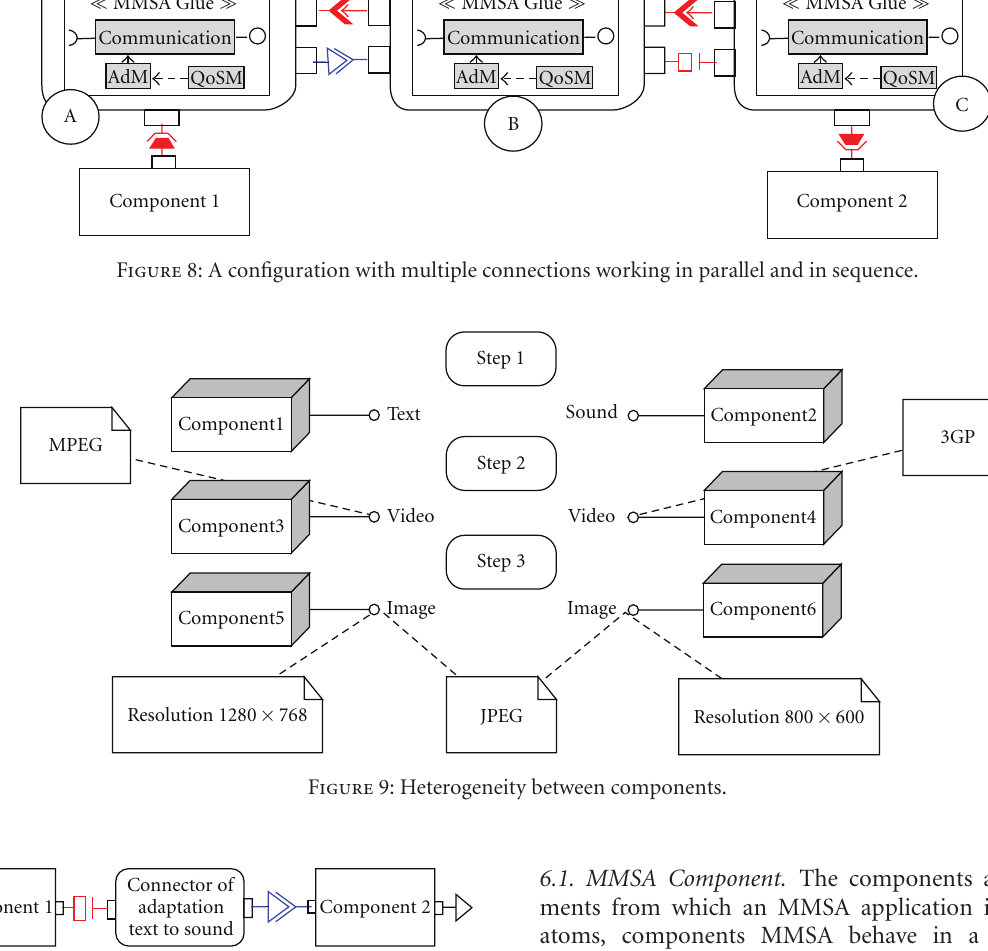
Figure 10: Transmoding connector of text toward sound.